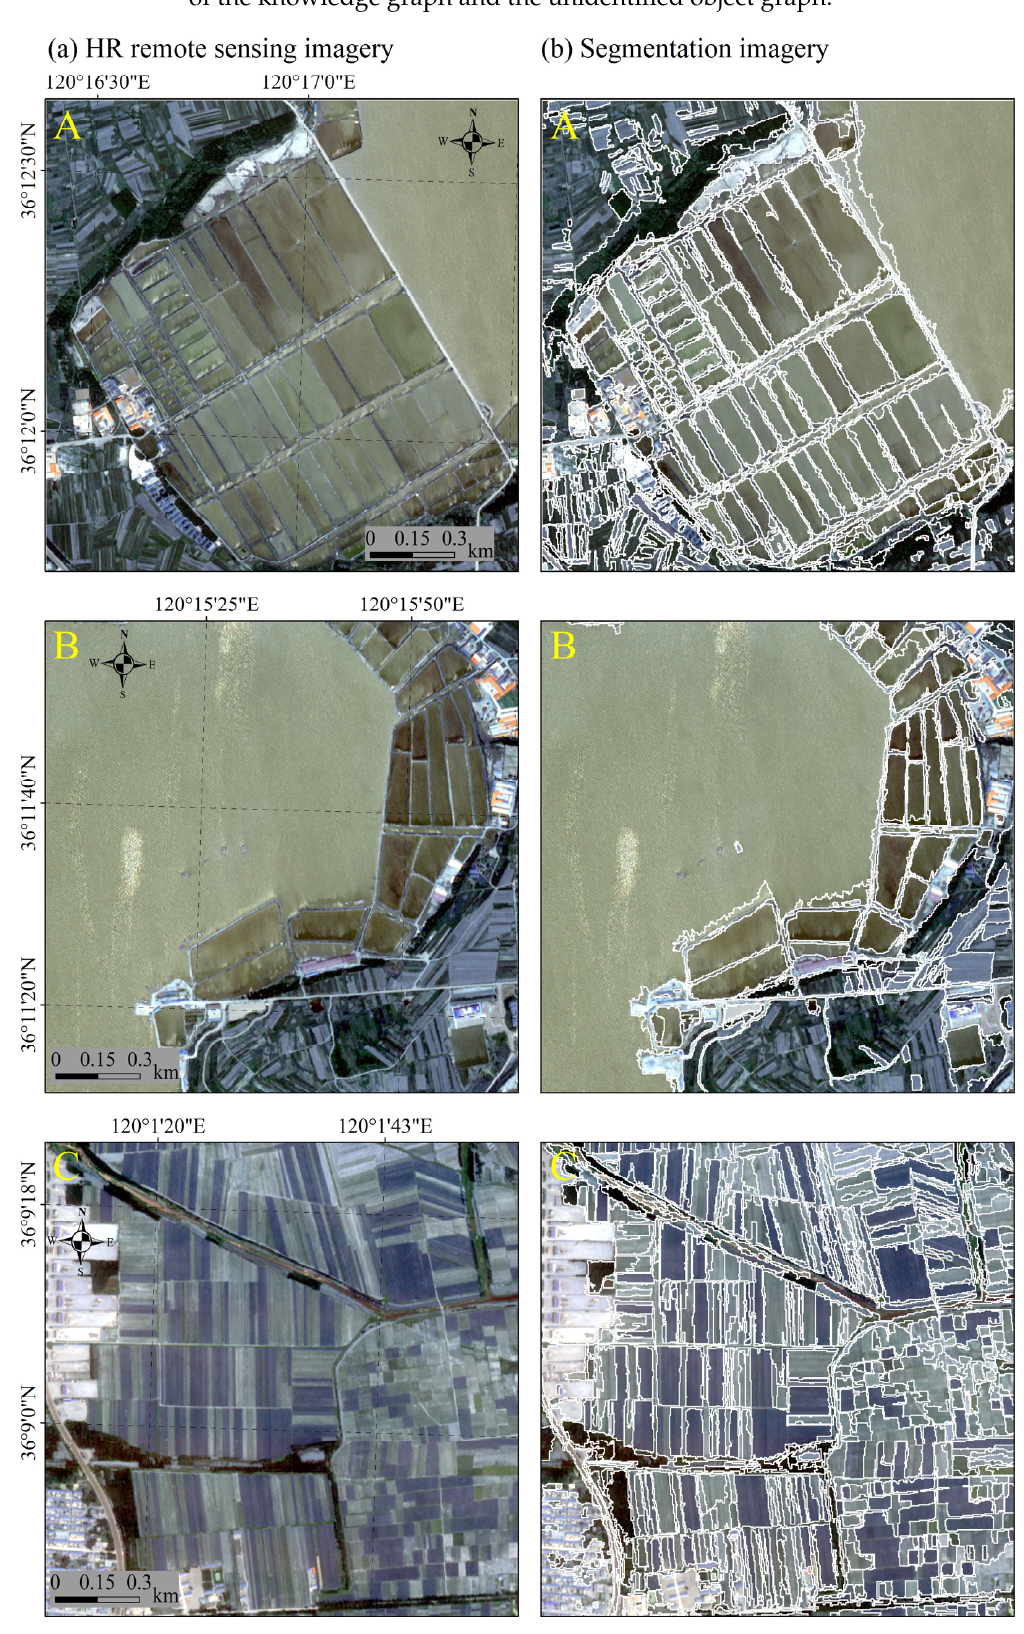
Figure 9. Experimental imagery and segmentation imagery produced by the UMSO algorithm.